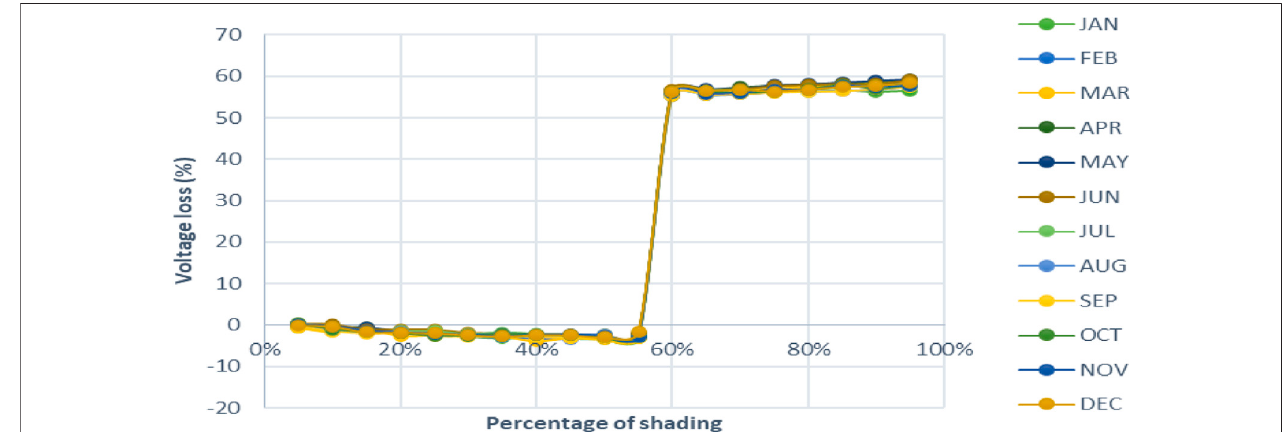
FIGURE 11 | Monthly voltage losses